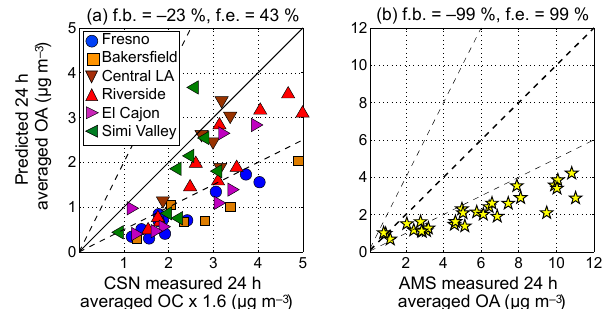
Figure 3. Scatter plot of VBS-IVOC OA predictions versus 24h measurements from (a) filters collected at sites in the Chemical Speciation Network (CSN) and (b) HR-AMS measurements at the Pasadena ground site during the CalNex campaign. In panel (a) the model–measurement comparison is for six sites in California (Fresno, Bakersfield, Central Los Angeles, Riverside, El Cajon, and (cid:18) (cid:19) P N P − M 1 Simi Valley). f.b. is the fractional bias and f.e. i = 1 N P + M 2 (cid:18) (cid:19) | P − M | P N 1 is the fractional error ; P is the predicted value, Figure 4. Averaged, normalized composition of OA at the Pasadena i = 1 N P + M 2 ground site as predicted by the Traditional and VBS-IVOC models. M is the measured value and N is the sample size. Predictions are compared to PMF factors derived from ambient HR- AMS data collected in Pasadena Hayes et al.